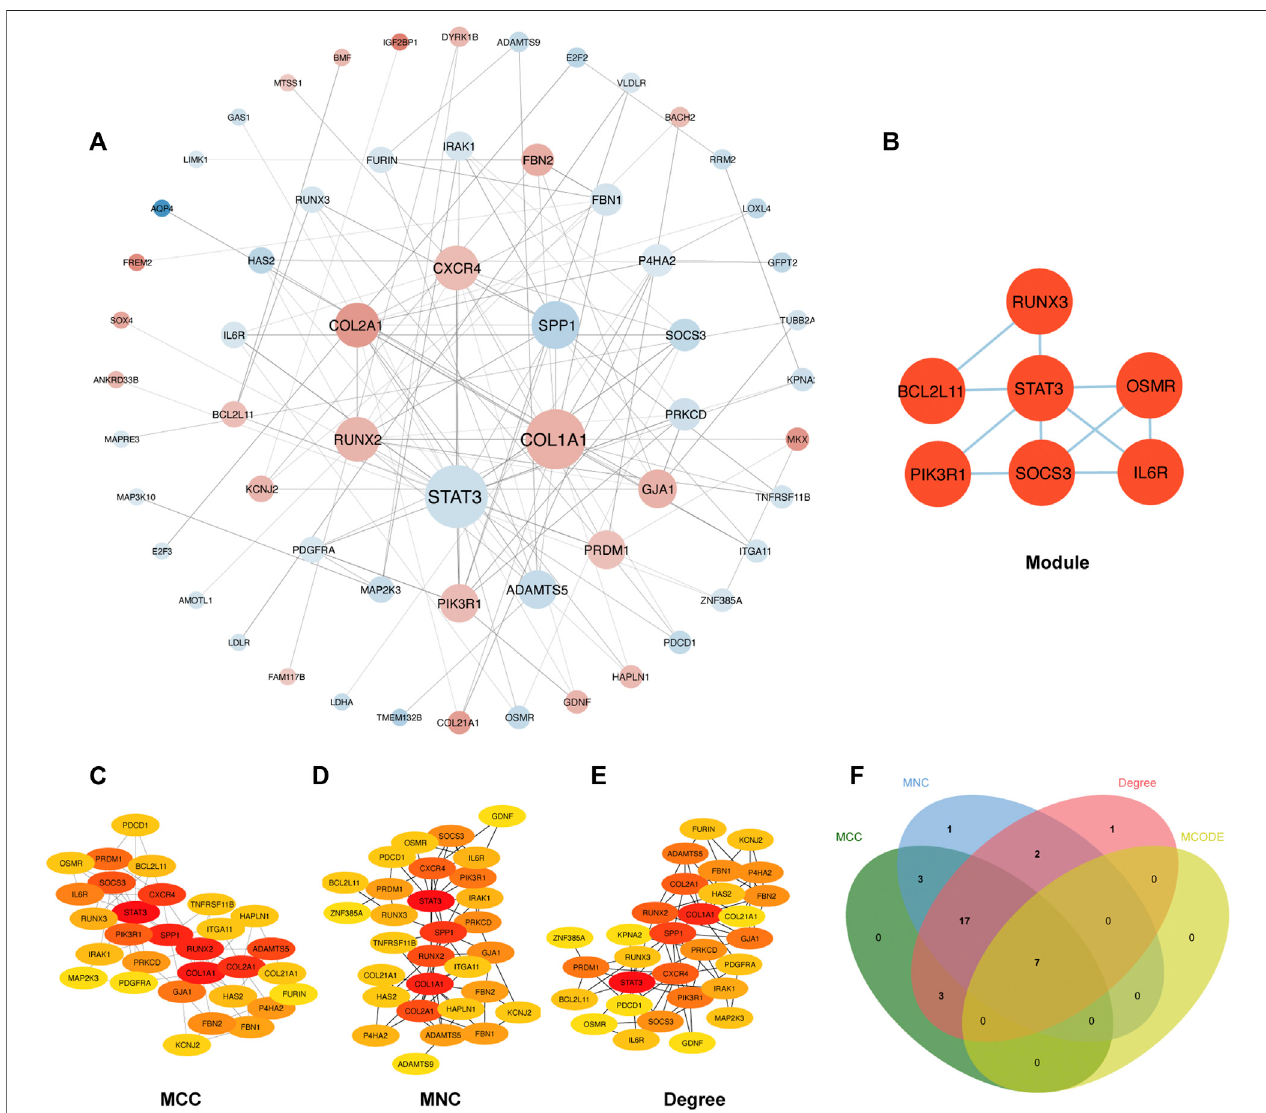
FIGURE8| ConstructionofPPInetworkandidenti fi cationofhubgenes. (A) ThePPInetworkof88mRNAswasselectedbycrossover.Redindicatesupregulation, blue indicates downregulation, and color depth indicates upregulation degree. The size of the circle indicates the size of the degree value. (B) Key module of the PPI network. (C – E) The hub genes were identi fi ed using four models (Degree, MCC, MNC, and Degree). (F) Venn diagram was used to identify the 7 hub genes in TOF.